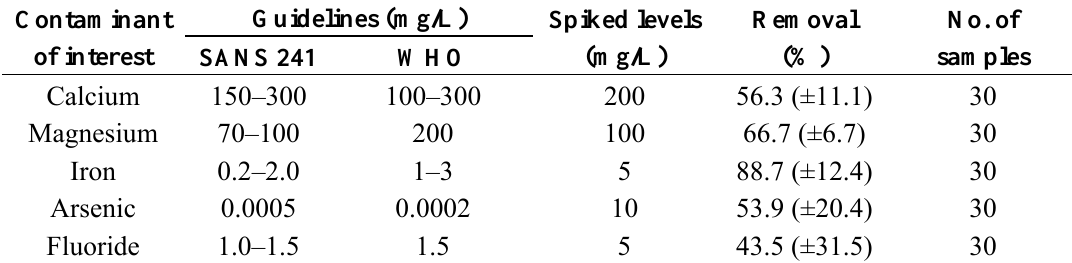
Table 1. Chemical profile of spiked water samples for preliminary